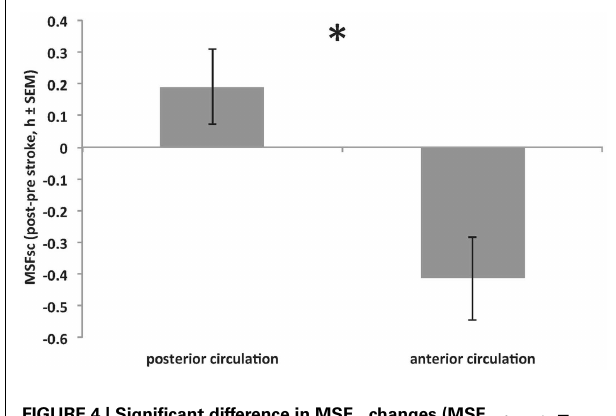
FIGURE 4 | Significant difference in MSF sc changes (MSF sc-afterstroke − MSF sc-beforestroke ) between strokes within the anterior circulation (middle, anterior and posterior cerebral artery and anterior choroidal artery; providing blood to the cerebrum) and strokes within the posterior circulation (ventrobasilar and vertebrobasilar artery; proving blood to the cerebellum and brain stem) (* p = 0.016, Mann–Whitney U test) . Positive values on y -axis indicate MSF sc advances. See also Table 1 for stroke